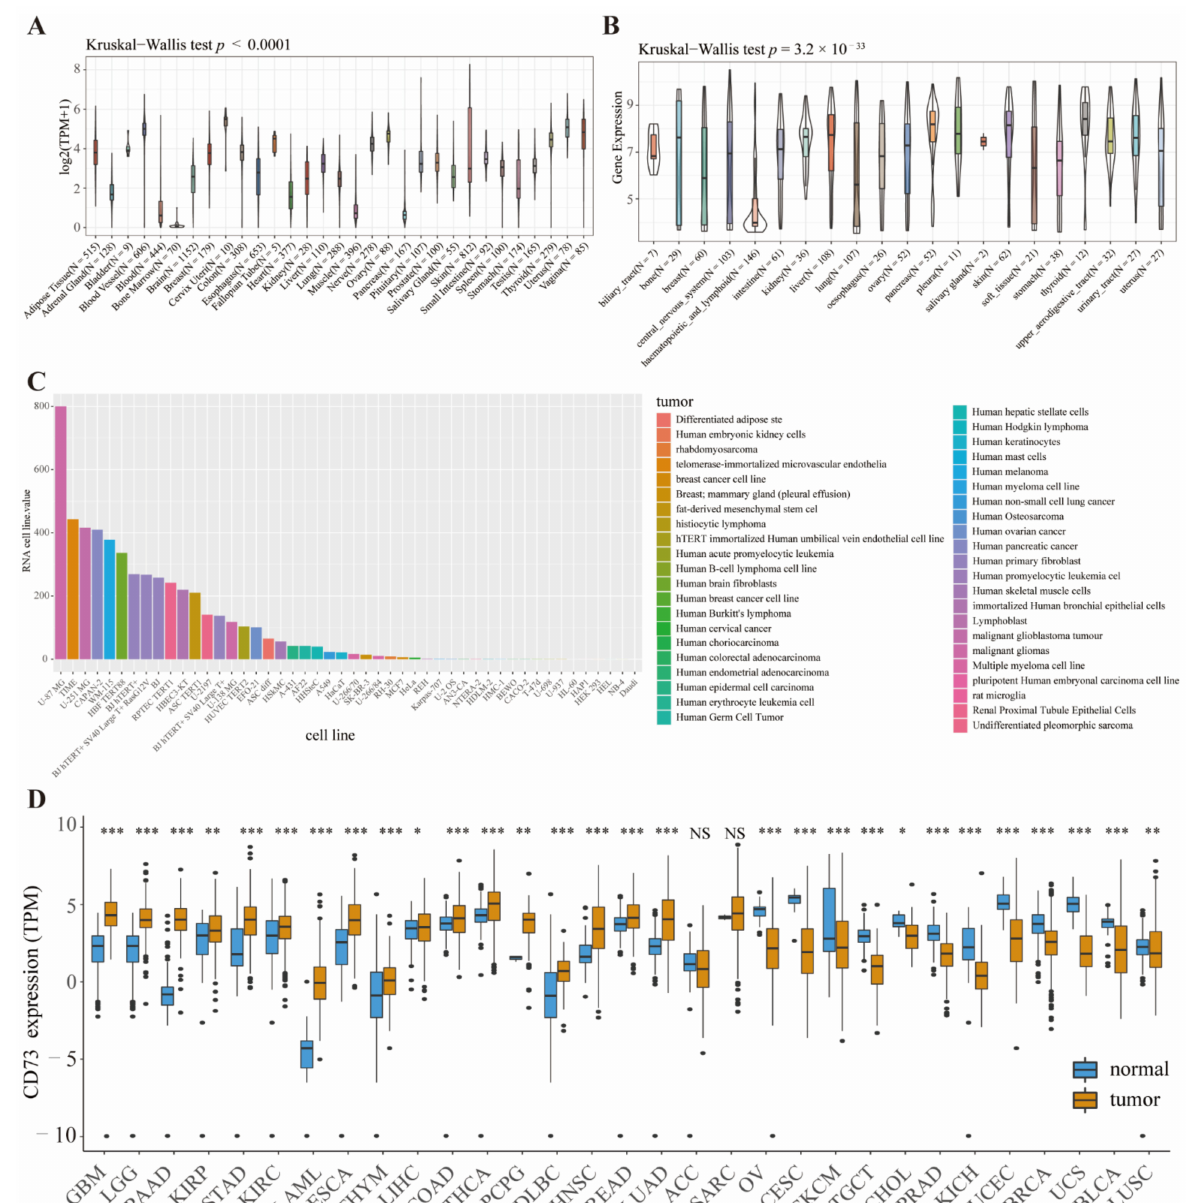
Figure 1. CD73 is widely expressed in cancer cell lines, normal and tumor tissues. CD73 expression in human normal tissues ( A ). CD73 expression in cancer cell lines from CCLE ( B ) and HPA ( C ) databases. CD73 expression in normal and tumor tissues from TCGA and GETx ( D ) databases. * p < 0.05, ** p < 0.01, *** p < 0.001, NS: no significant